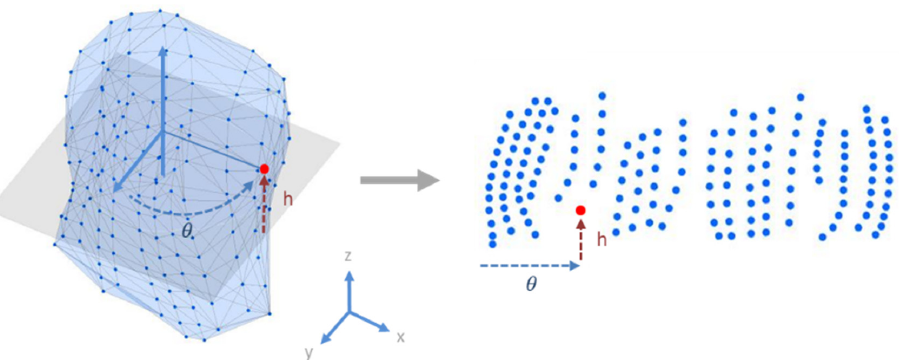
Figure 3. Registration of the torso nodes to the 2D plane. The torso node geometry data were first centered on the geometric origin, and then the nodes were projected to a cylinder surface. θ is the degree from the y -axis to the node and h is the height from the x – y plane to the node.